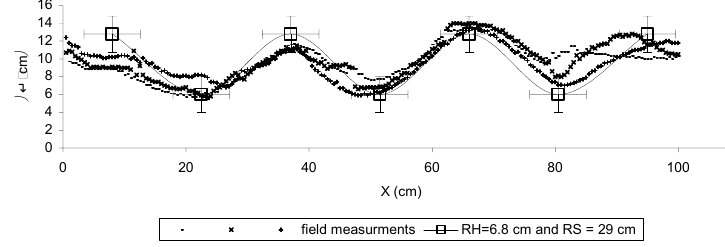
Fig. 6. Laser profilograph measurements of ridge characteristics ( RH , ridge height; RS , ridge spacing) at the experimental field. FIGURE 6 Table 4. Measured characteristics of ridges (spacing: RS ; height: RH ) at the experimental agricultural field using laser